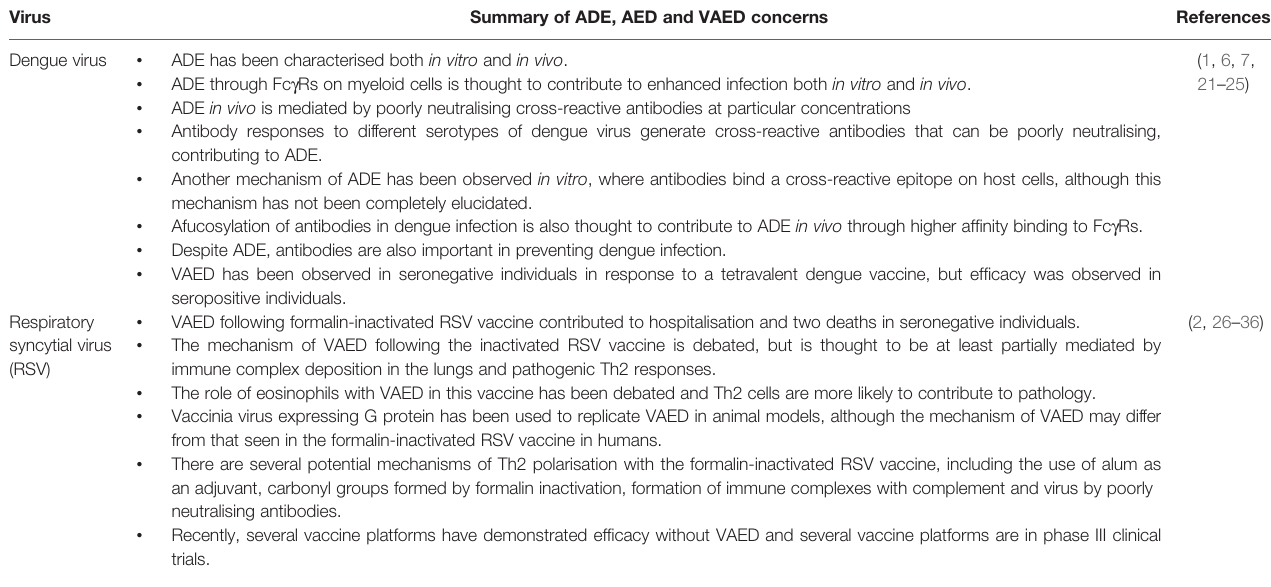
TABLE 1 | An overview of ADE, AED and VAED concerns relevant to dengue virus and RSV. Virus Summary of ADE, AED and VAED